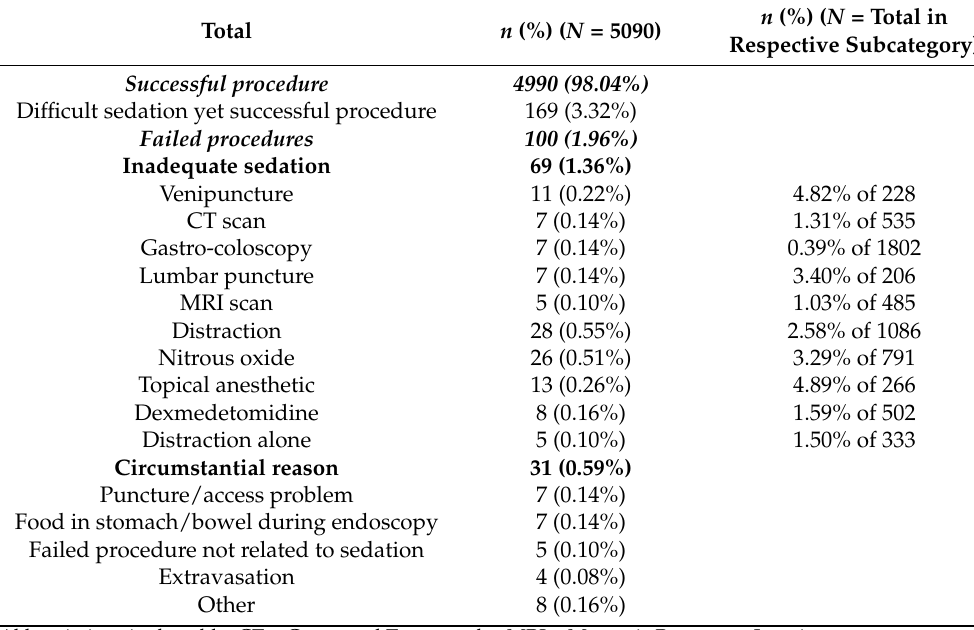
Table 6. Overall efficacy of sedations and failed procedure according to used method and type of